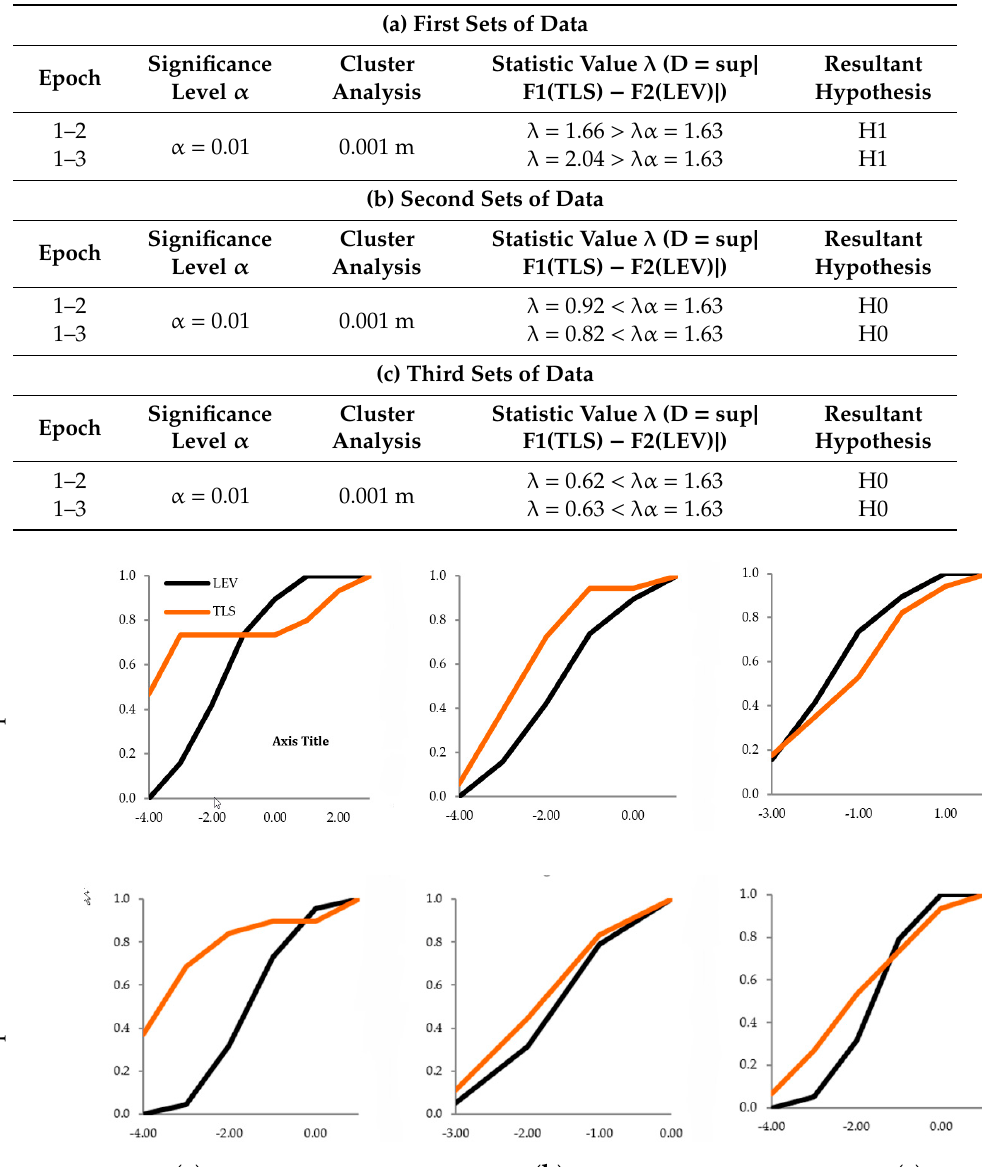
Table 9. Two-sample K-S test results TLS vs. LEV (leveling), case study 2; ( a ) First set of data, ( b ) Second set of data, and ( c ) Third set of data.